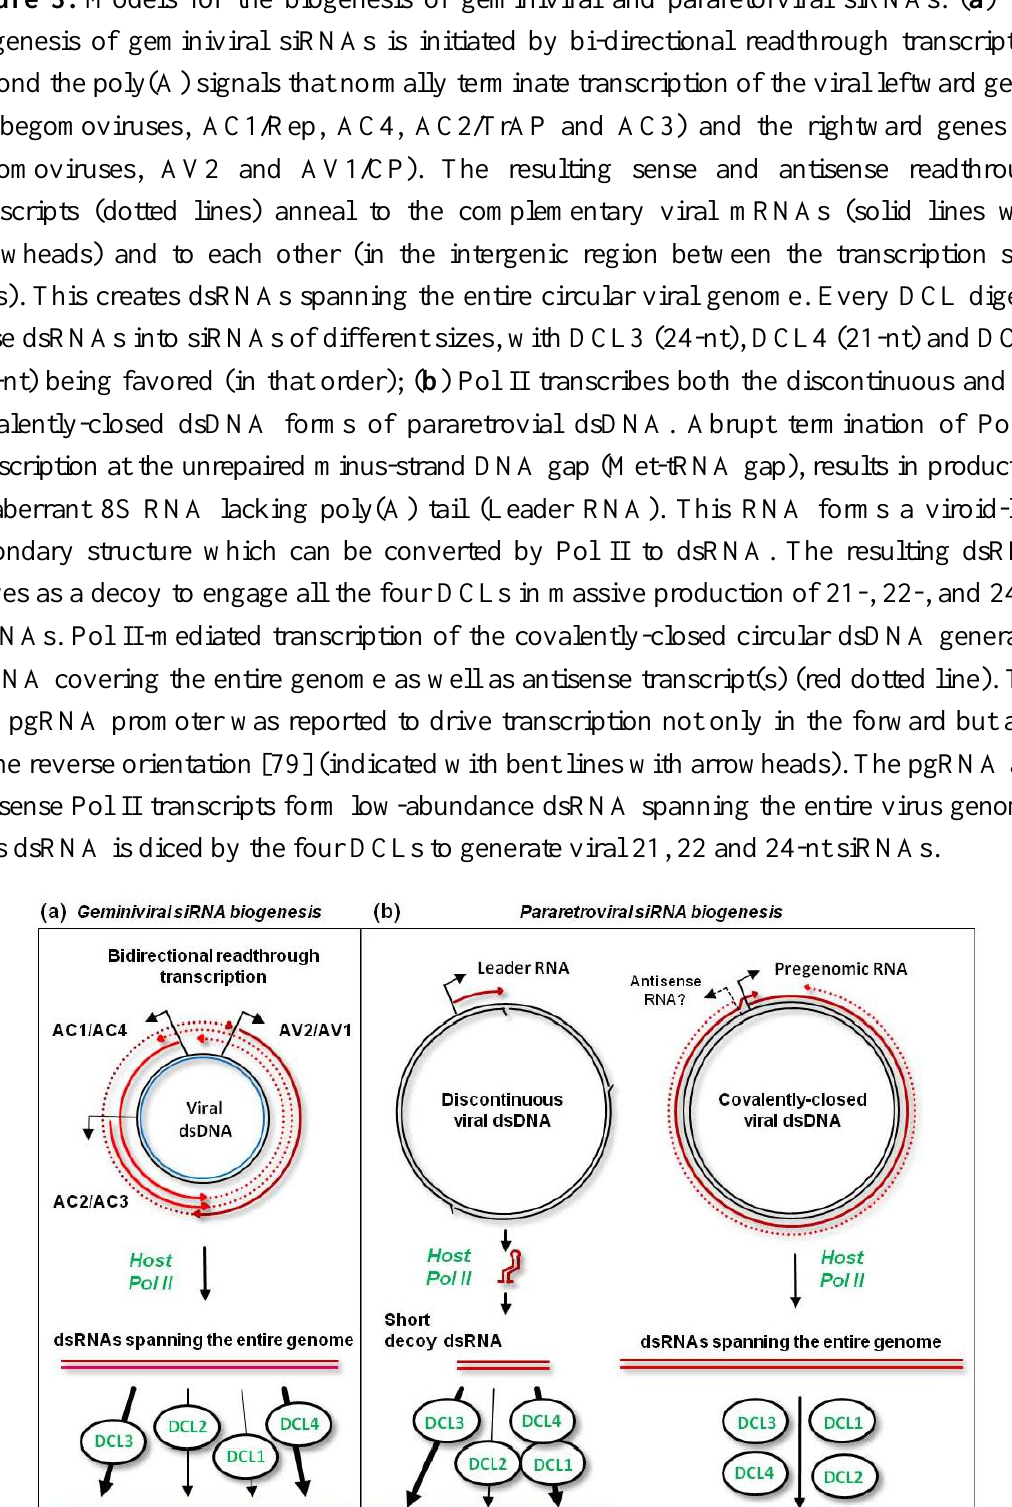
lower for those geminiviruses that are strictly limited to phloem tissues. Taking into account the dilution factor, geminivirus-infected phloem cells must produce massive amounts of viral siRNAs. Figure 3. Models for the biogenesis of geminiviral and pararetorviral siRNAs. ( a ) The biogenesis of geminiviral siRNAs is initiated by bi-directional readthrough transcription beyond the poly(A) signals that normally terminate transcription of the viral leftward genes (in begomoviruses, AC1/Rep, AC4, AC2/TrAP and AC3) and the rightward genes (in begomoviruses, AV2 and AV1/CP). The resulting sense and antisense readthrough transcripts (dotted lines) anneal to the complementary viral mRNAs (solid lines with arrowheads) and to each other (in the intergenic region between the transcription start sites). This creates dsRNAs spanning the entire circular viral genome. Every DCL